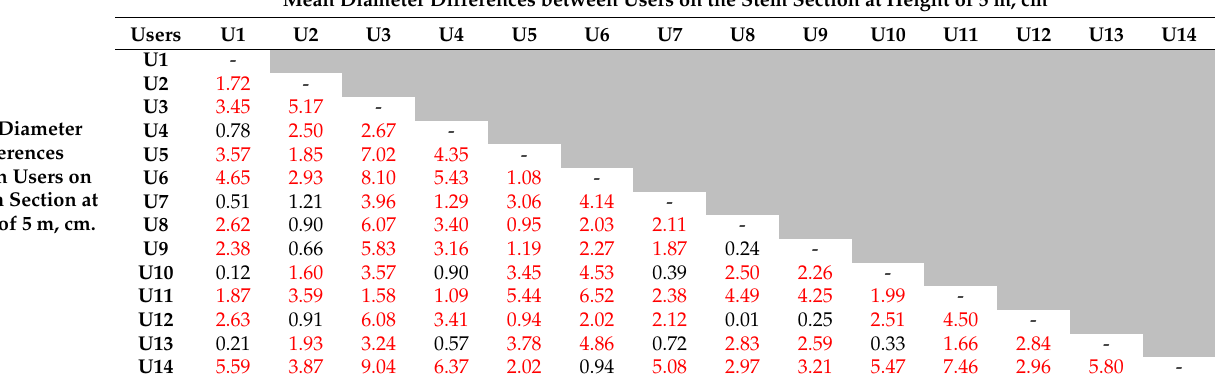
Table A3. Differences between mean diameters obtained by each user when a laser caliper was used to measure upper-stem diameters at a height of 5 m. The red values denote significant differences between the mean diameters obtained by the users.